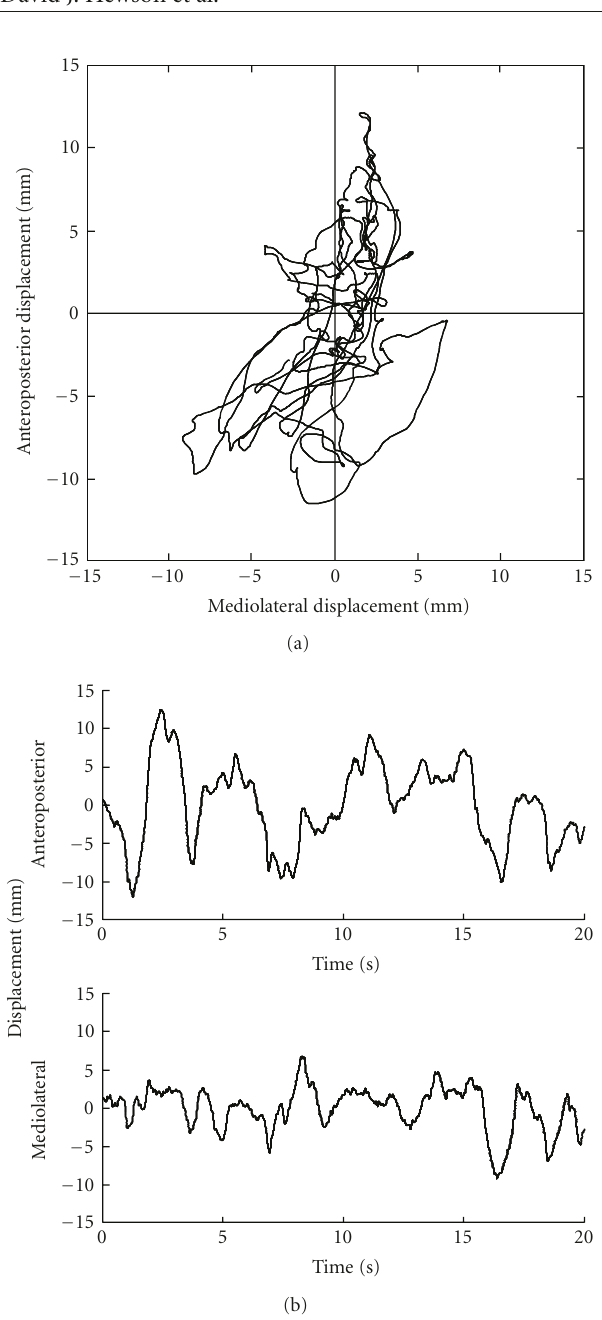
Figure 1: Typical stabilogram of the displacement of the centre of pressure (COP). Data are for a healthy 24-year-old adult